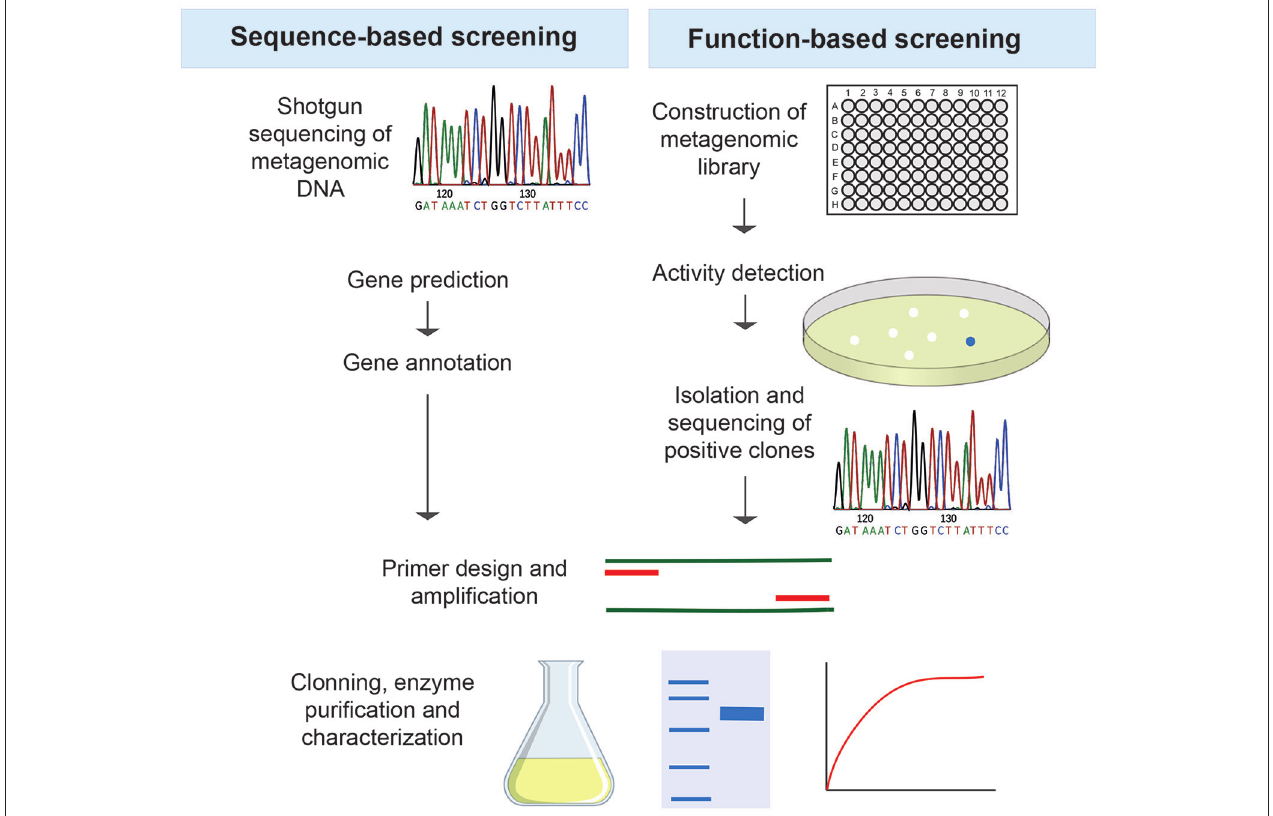
FIGURE 2 | The two major strategies used for screening metagenomes in search of new